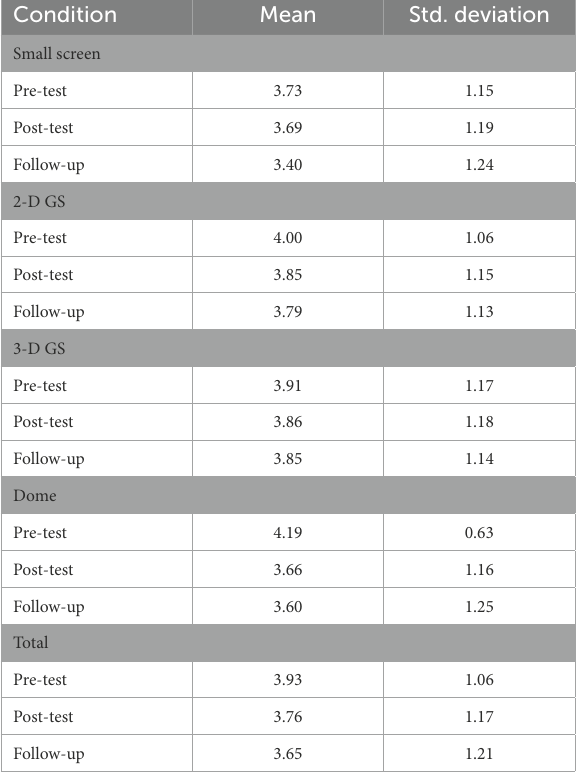
TABLE 3C Descriptives for posttest and followup natural section science knowledge.